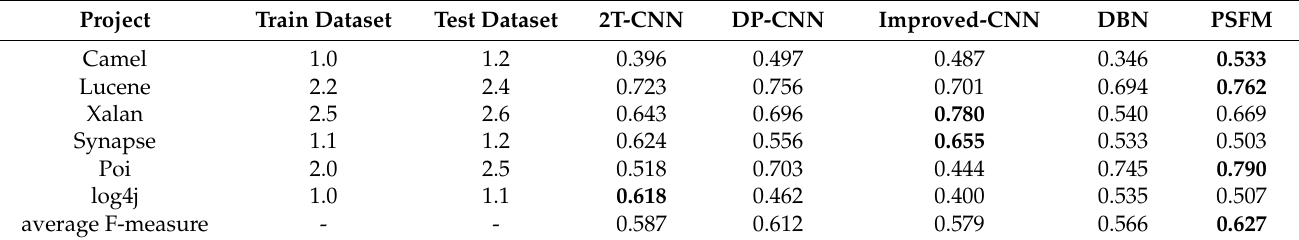
Table 2. F-measure comparison of the different methods.